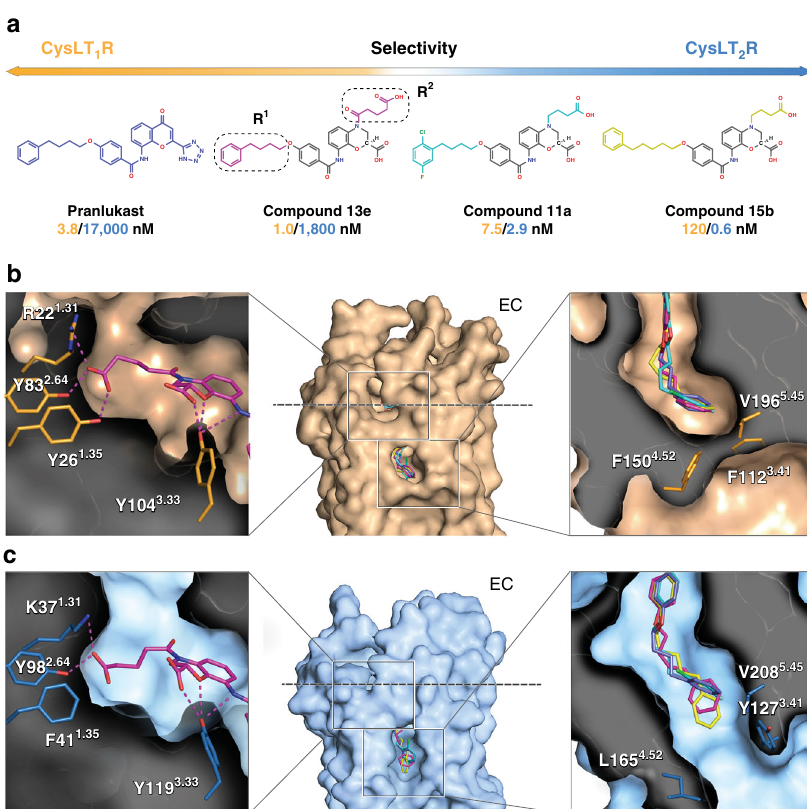
Fig. 3 Structural determinants of antagonist selectivity to CysLTR subtypes. a Examples of compounds used in the docking studies, with their IC 50 values toward CysLT 1 R and CysLT 2 R shown in yellow and blue, respectively. IC 50 values for pranlukast were obtained in this work (3.8 ± 0.7 nM (CysLT 1 R) and ~17,000 ± 12,000 nM (CysLT 2 R), expressed as mean ± s.d. of three independent experiments, tested in quadruplicate) and for other ligands were quoted from ref. 30 . The common 3,4-dihydro-2H-1,4-benzoxazine-2-carboxylic acid scaffold is shown in gray. Overview of the ligand-binding pocket with the docked ligands for CysLT 1 R ( b ) and CysLT 2 R ( c ). Inserts show docking poses and details of ligand interactions with CysLT 1 R and CysLT 2